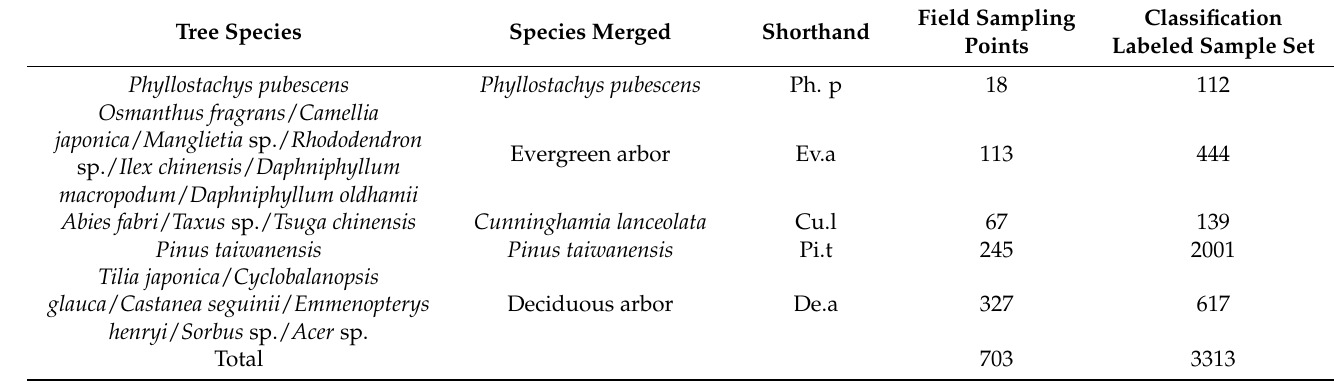
Table 2. The remote sensing sample set of